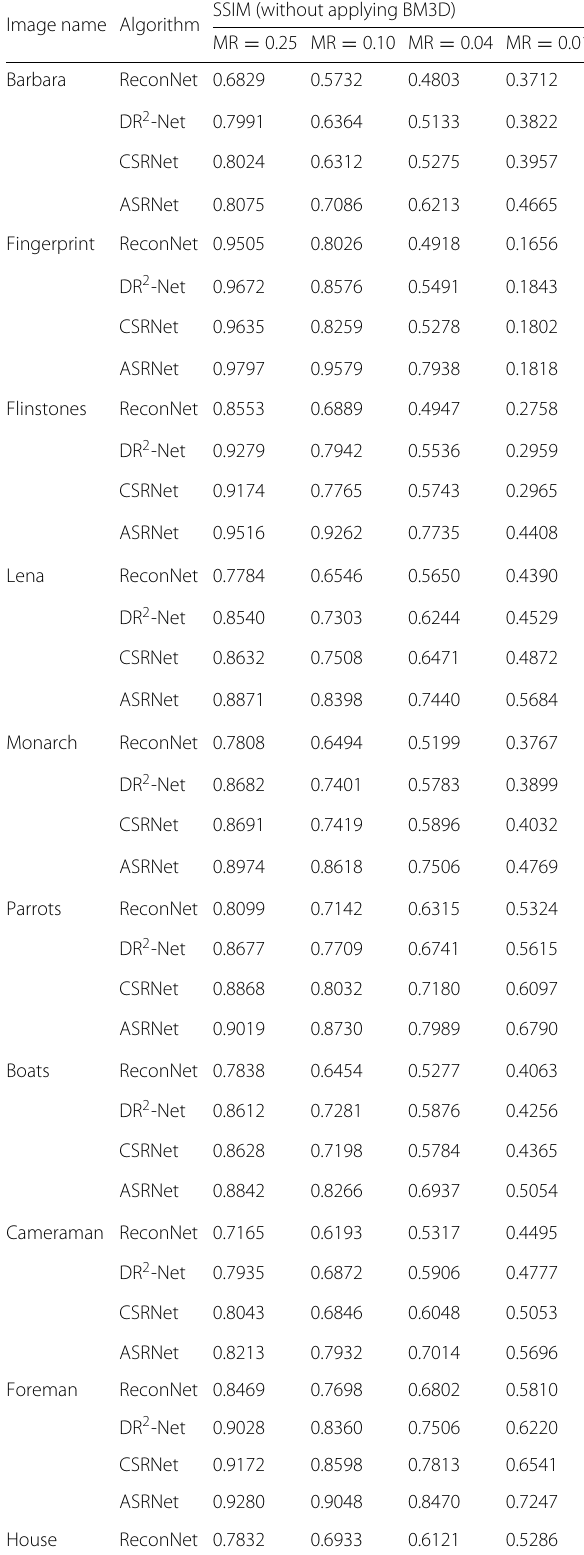
Table 2 SSIM valves in dB for testing image by different algorithms at the ratio MR = 0.25, 0.1, 0.04, and 0.01 ( Continued ) SSIM (without applying Image name Algorithm